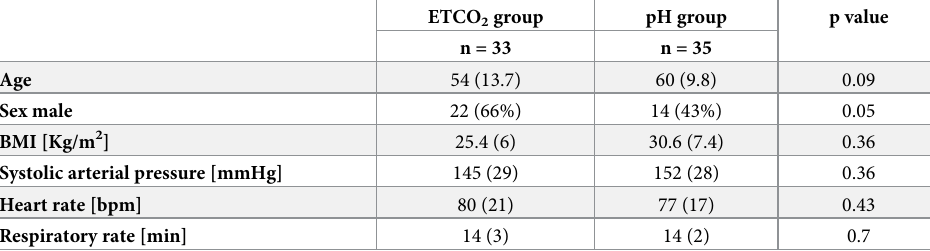
The ETCO ROC curve analysis for predicting NGT tracheal misplacement (Fig 4A) demon- 2 strated a perfect diagnostic accuracy with an AUC of 1.0 (CI 95%, 1.0 to 1.0, p < 0.001); the Table 1. Demographics characteristic population.